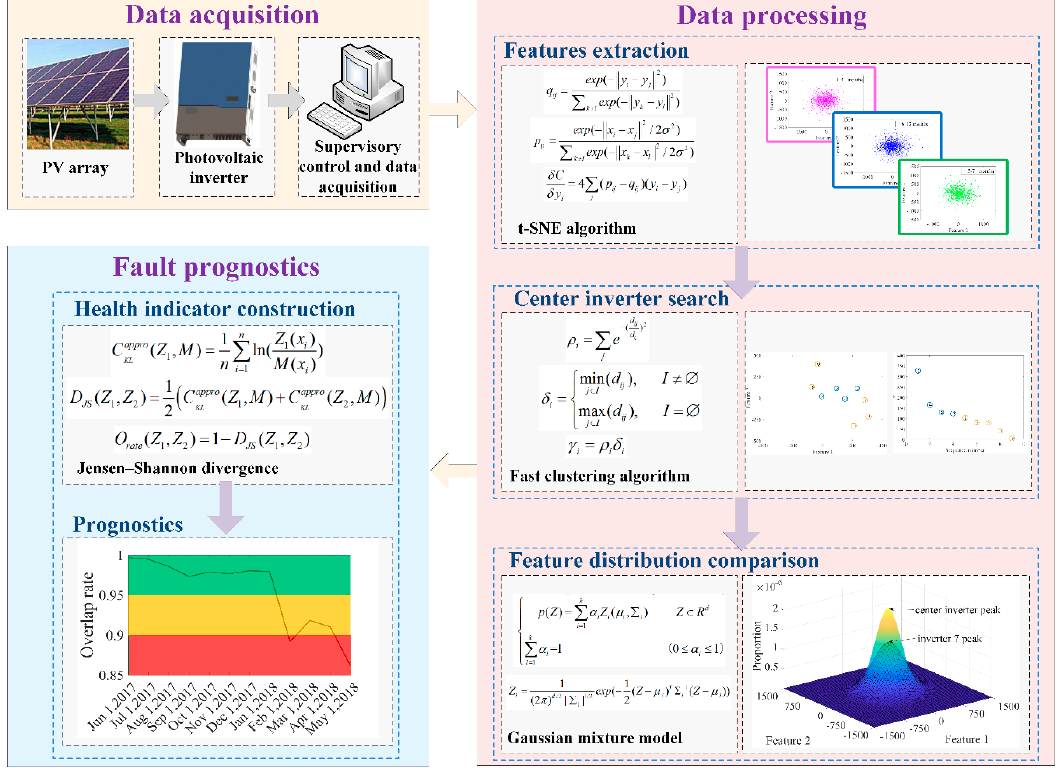
Figure 1. Main technical framework of this paper.